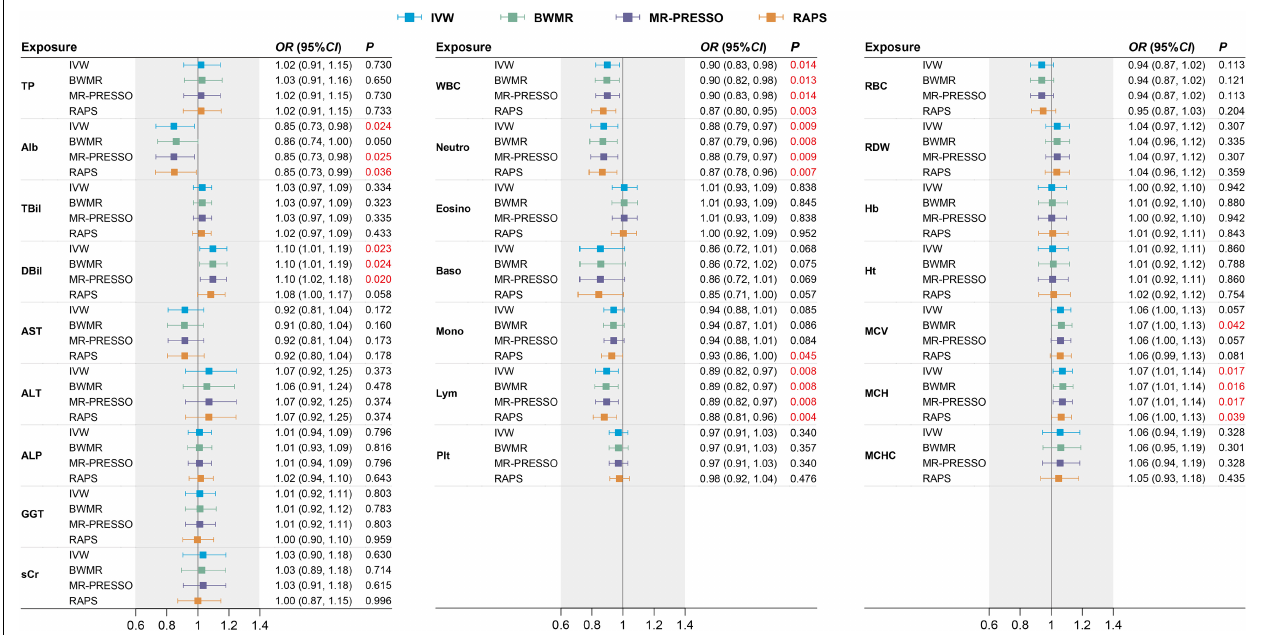
FIGURE 2 | Causal effects on severe COVID-19 estimated by two-sample MR analysis for 23 liver and kidney function biomarkers and blood cell traits. Effect sizes are represented by OR per SD increment in the exposure. The horizontal bars represent 95% CI. Significant P values ( < 0.05) are highlighted in red. TP, total protein; Alb, albumin; TBil, total bilirubin; DBil, direct bilirubin; AST, aspartate aminotransferase; ALT, alanine aminotransferase; ALP, alkaline phosphatase; GGT, γ -glutamyl transferase; sCr, serum creatinine; WBC, white blood cell count; Neutro, neutrophil count; Eosino, eosinophil count; Baso, basophil count; Mono, monocyte count; Lym, lymphocyte count; RBC, red blood cell count; RDW, red cell distribution width; Hb, hemoglobin; Ht, hematocrit; MCV, mean corpuscular volume; MCH, mean corpuscular hemoglobin; MCHC, mean corpuscular hemoglobin concentration; Plt, platelet